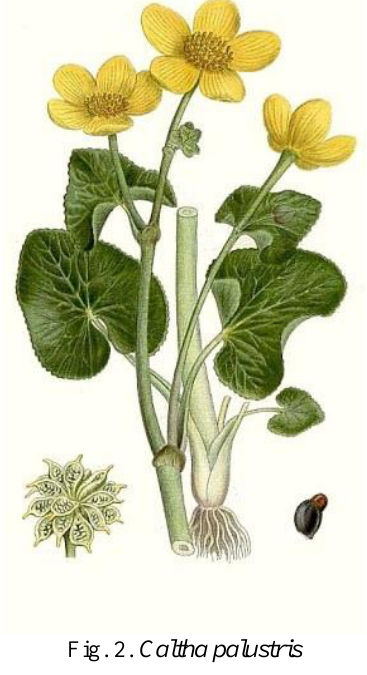
Fig. 2. Caltha palustris Distribution and harvesting.